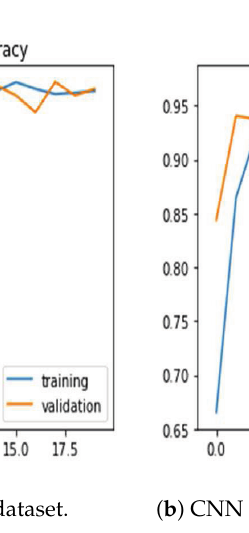
Figure 5. Training and validation loss for the three architectures trained using the public and the fused datasets. Note that VGG-16 trained on the fused dataset ended after one epoch only, hence there is no corresponding figure. The models are able to properly fit training data and improve with experience (as seen in validation curves).